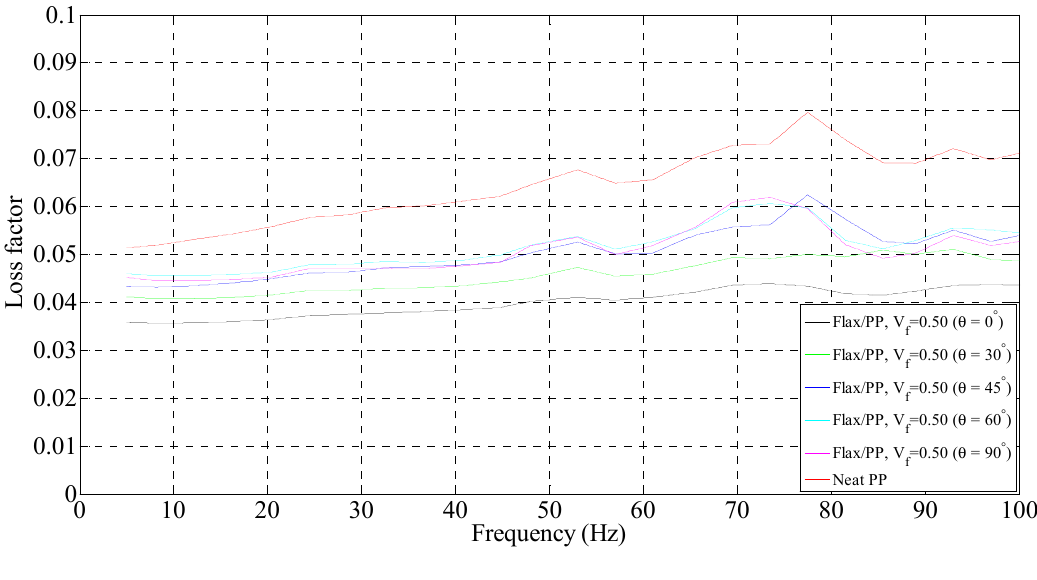
Figure 9. Loss factor of flax/PP composite samples of different fibre orientations for a fibre volume fraction of 0.50 and a neat PP sample.